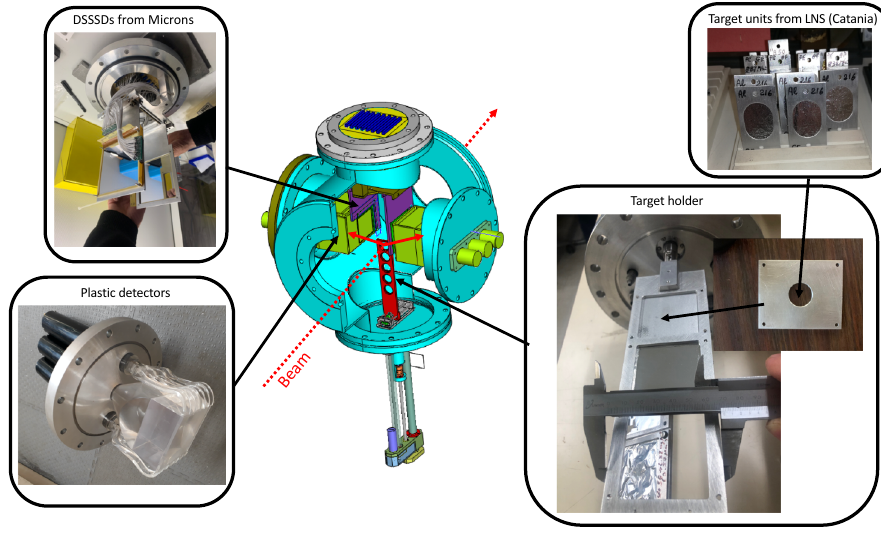
Figure 2. Mechanical scheme (at the center) of the New JEDI setup (first version) and pictures of its components (chamber, detectors, target holder and